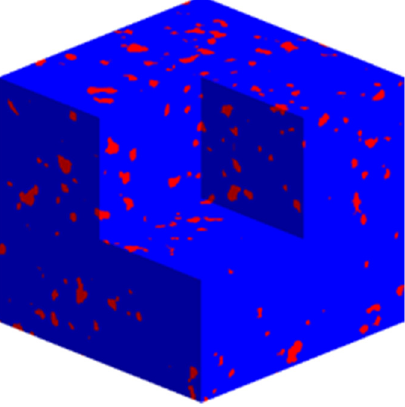
Figure 2. Y288-10 three-dimensional digital rock.